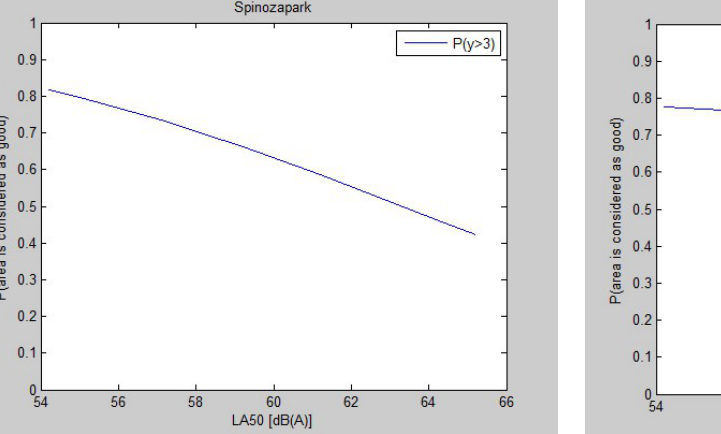
Figure 7: Probability that the end users consider an area as good (score of at least 3 out of 5) as the noise levels (expressed in terms of LA50 parameter) change in Florence pilot areas.